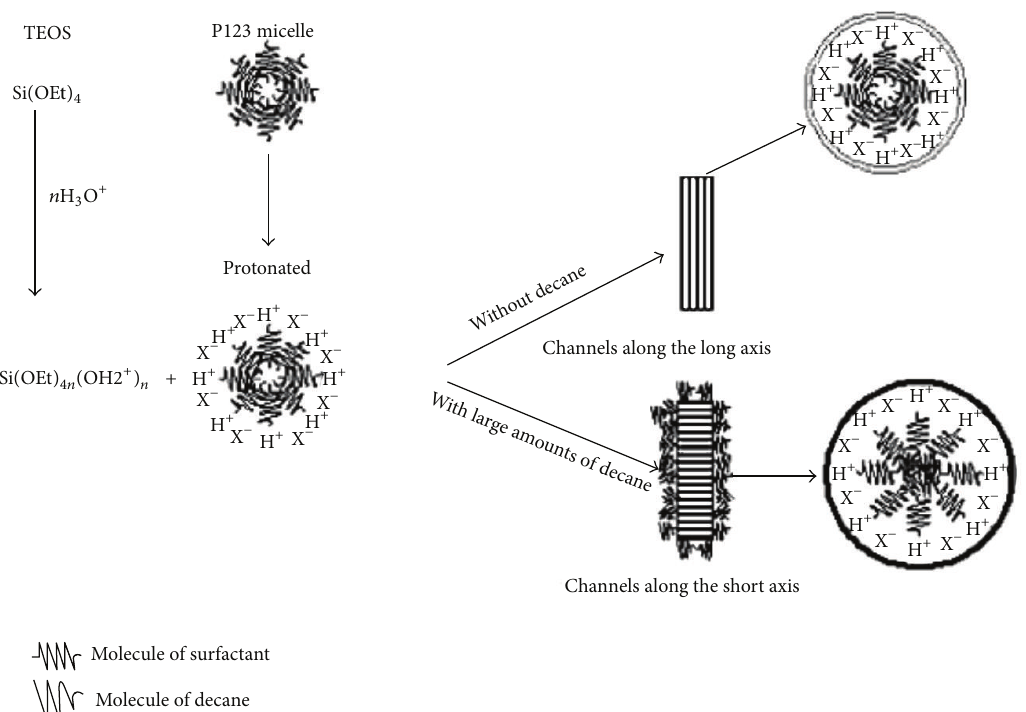
Figure 4: Schematic representation of the bifunctional roles of large amounts of decane. Reprinted with permission from [34]. Copyright (2004) American Chemical Society.